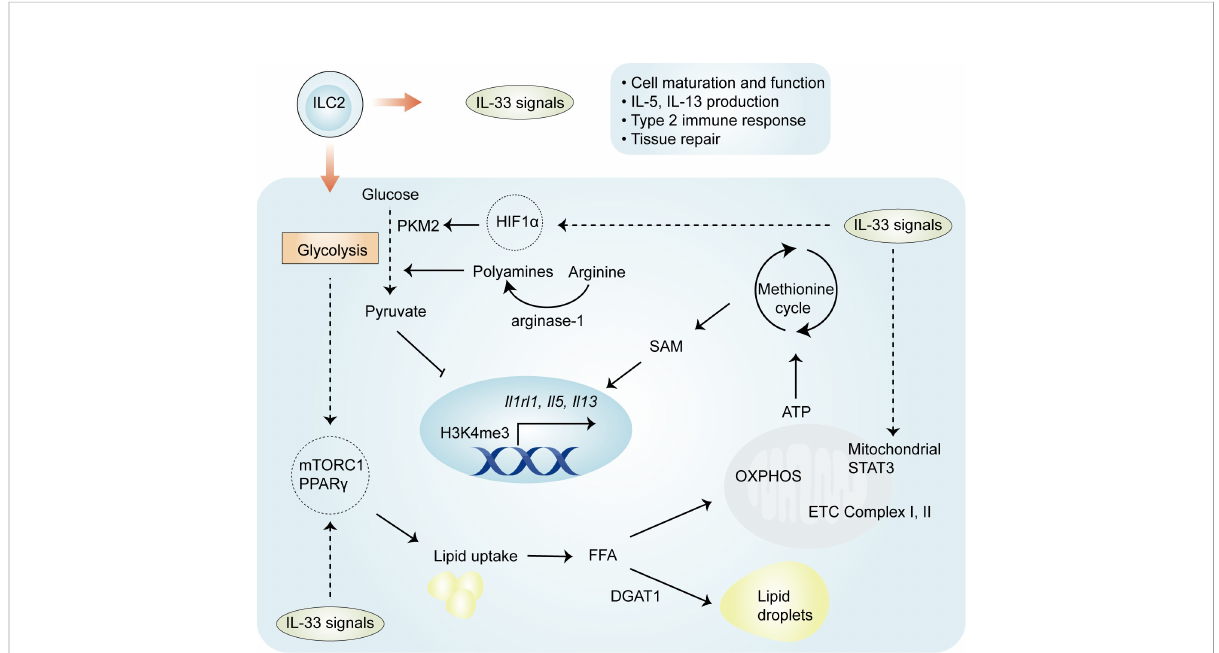
FIGURE 2 Regulation of ILC2 metabolism by IL-33. Both glycolysis and OXPHOS are activated in IL-33-activated ILC2s, and the glycolytic process allows the uptake and storage of external lipids to fuel the proliferation of ILC2s. Four important regulators — HIF-1 a , STAT3, arginase-1, and PPAR g — have been implicated in IL-33-activated ILC2s. HIF-1 a drives the expression of the glycolytic enzyme PKM2 and the glycolytic metabolite pyruvate, which reduce H3K4me3 levels at ILC2-speci fi c genes. IL-33 drives the activation of STAT3 and subsequent generation of SAM, which leads to increased H3K4me3 levels. IL-33 also increases the expression of PPAR g , which mediates lipid metabolism in ILC2s. The enzyme arginase-1 promotes the generation of L -arginine-derived polyamines and is closely related to aerobic glycolysis in IL-33-activated ILC2s. OXPHOS, oxidative phosphorylation; PKM2, pyruvate kinase M2; SAM,